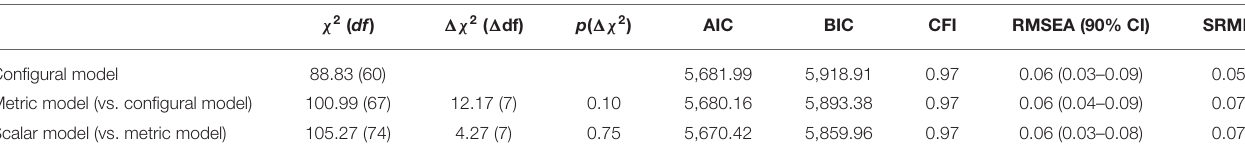
TABLE 2 | Factorial invariance of the HQ across age